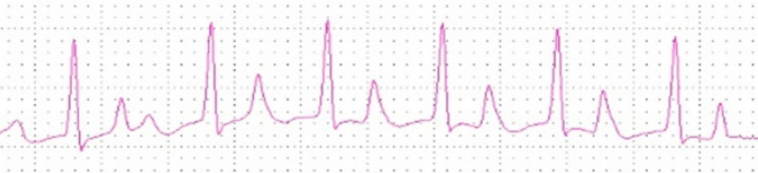
Figure 2. Supraventricular arrhythmia in dog with IRIS CKD Stage 4 after IHD session (25 mm/s; 1 cm = 1 mV). Table 1. Main arrhythmias observed in dogs with International Renal Interest Society (IRIS) chronic kidney disease (CKD) Stage 4 undergoing clinical treatment (CT) and intermittent haemodialysis (IHD) after three treatment sessions.